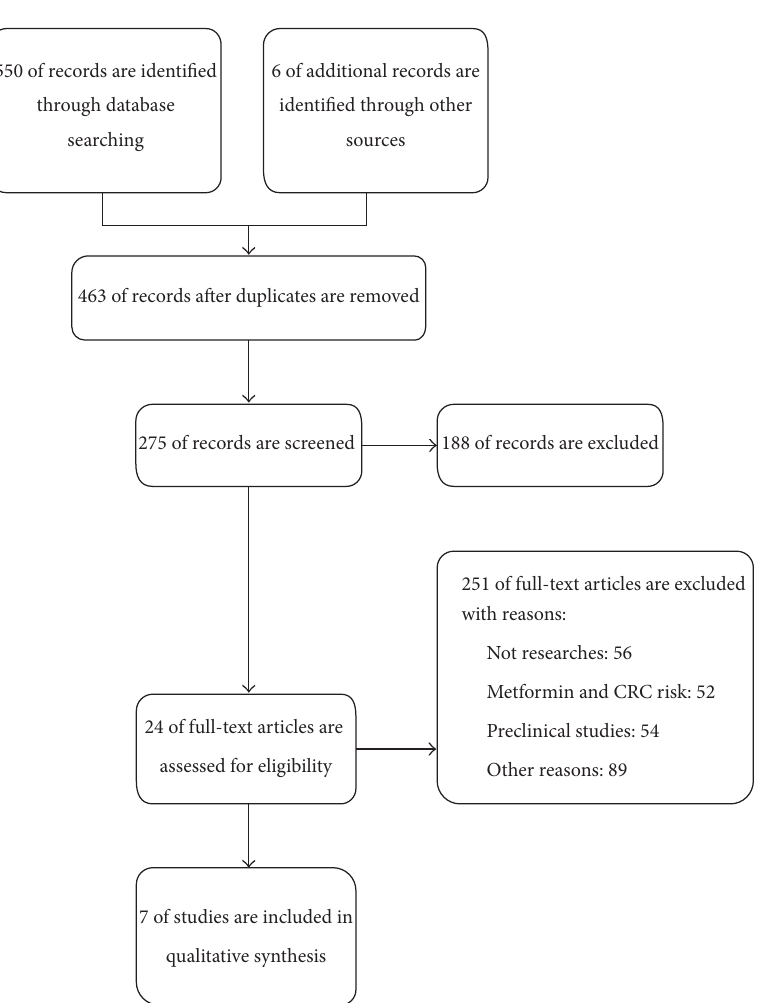
Figure 1: Flow diagram of studies included in the